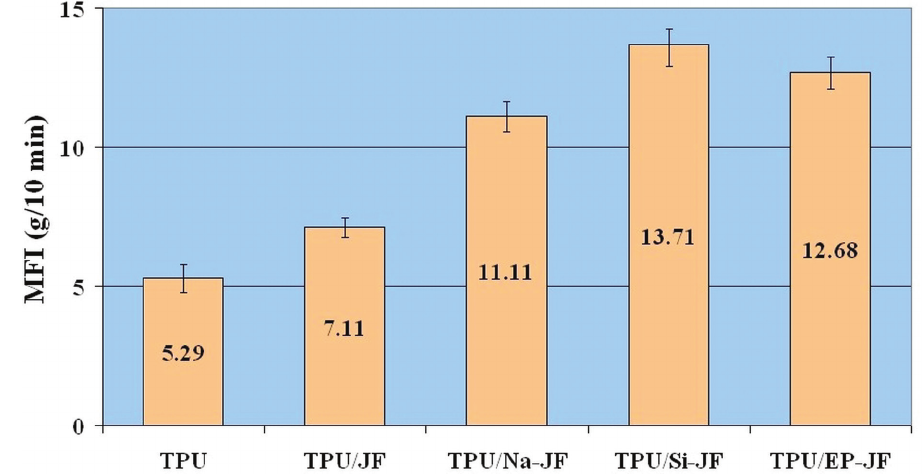
Figure 5: MFI values of TPU and